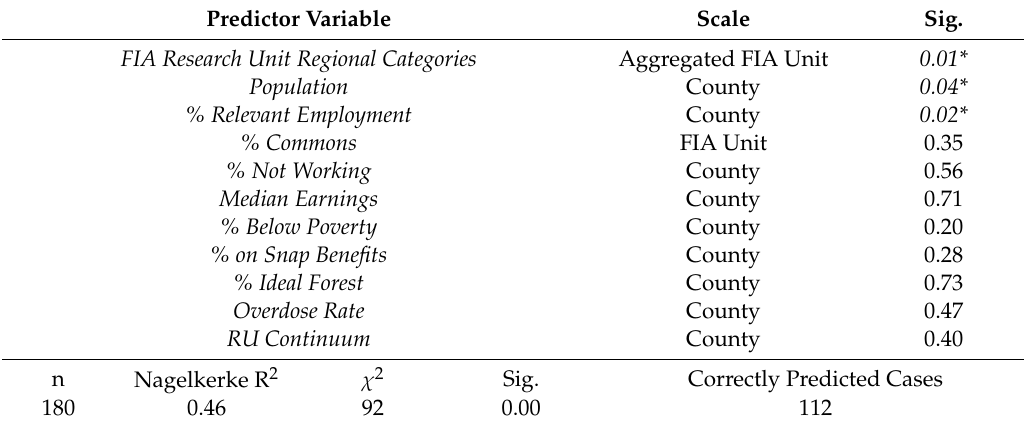
Table 3. Multinomial logistic regression predicting the probability that surveyed potential primary buyers of non-ginseng nontimber forest products (NTFPs) purchased o ff -root NTFP species, only ginseng, or nothing (results bottom of table). The model used biophysical and socioeconomic variables. Likelihood Ratio Estimates are included. FIA Research Unit Regional Categories , Population , and % Relevant Employment were significant predictors of whether buying behavior. Scale